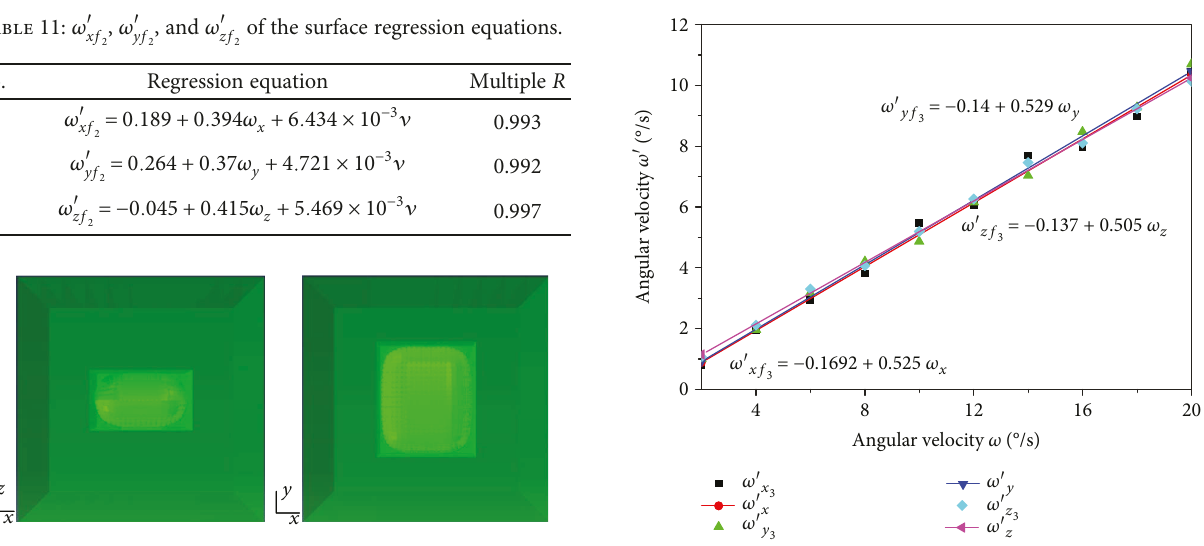
Figure 9: Finite element analysis model that couples the storage tank and microsatellite. Table 12: Material characteristics for the microsatellite. Density Material (kg/m 3 )